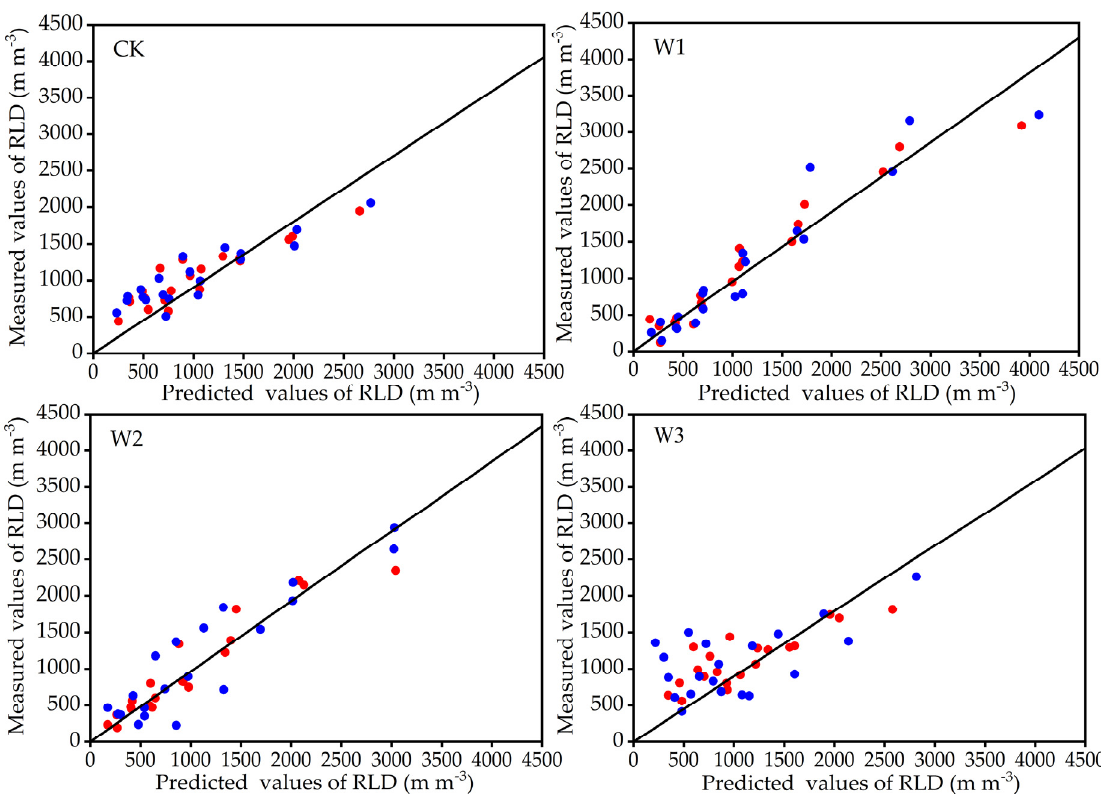
Figure 8. Relationships between measured RLD (root length density) and simulated RLD of jujube in 2018 (red dots) and 2019 (blue dots).